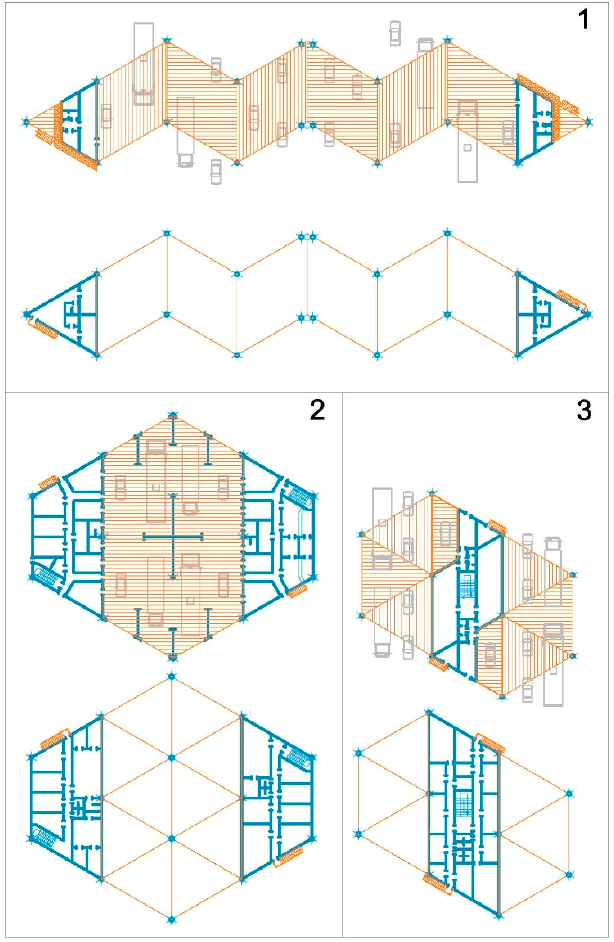
Figure 7. Planning solutions: 1—the Checkpoint (6 + 6 posts)—1st, 2nd floors; 2—the Service station (8 posts)—1st, 2nd floors; 3—the Traffic control point—1st, 2nd